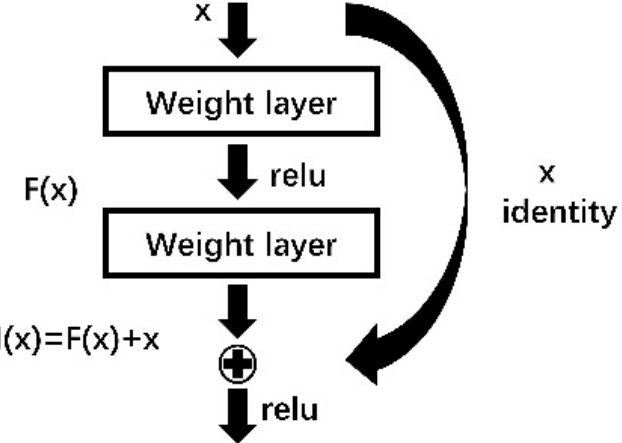
Figure 9. Architecture of the residual block to solve the degradation